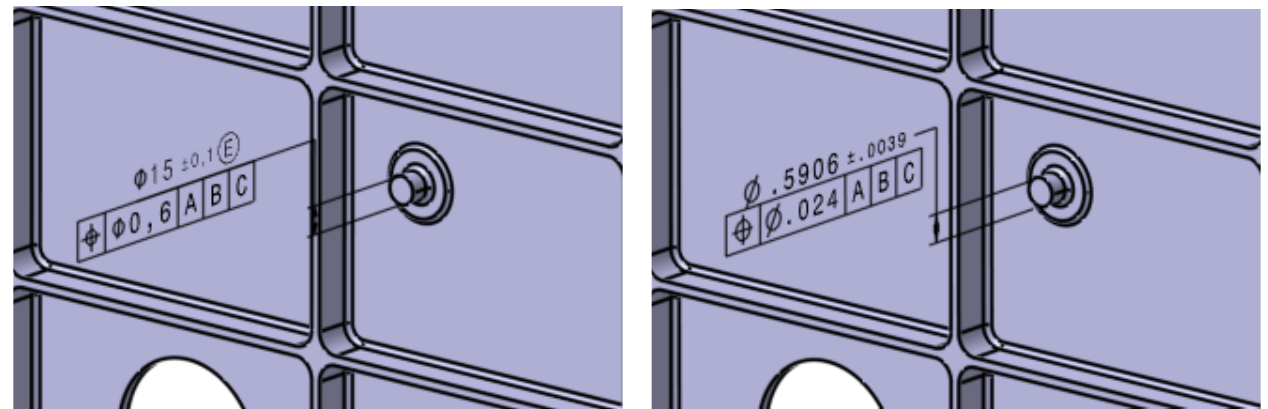
Figure A9. Pin specified in ISO model ( left illustration) and Pin specified in ASME model ( right il-